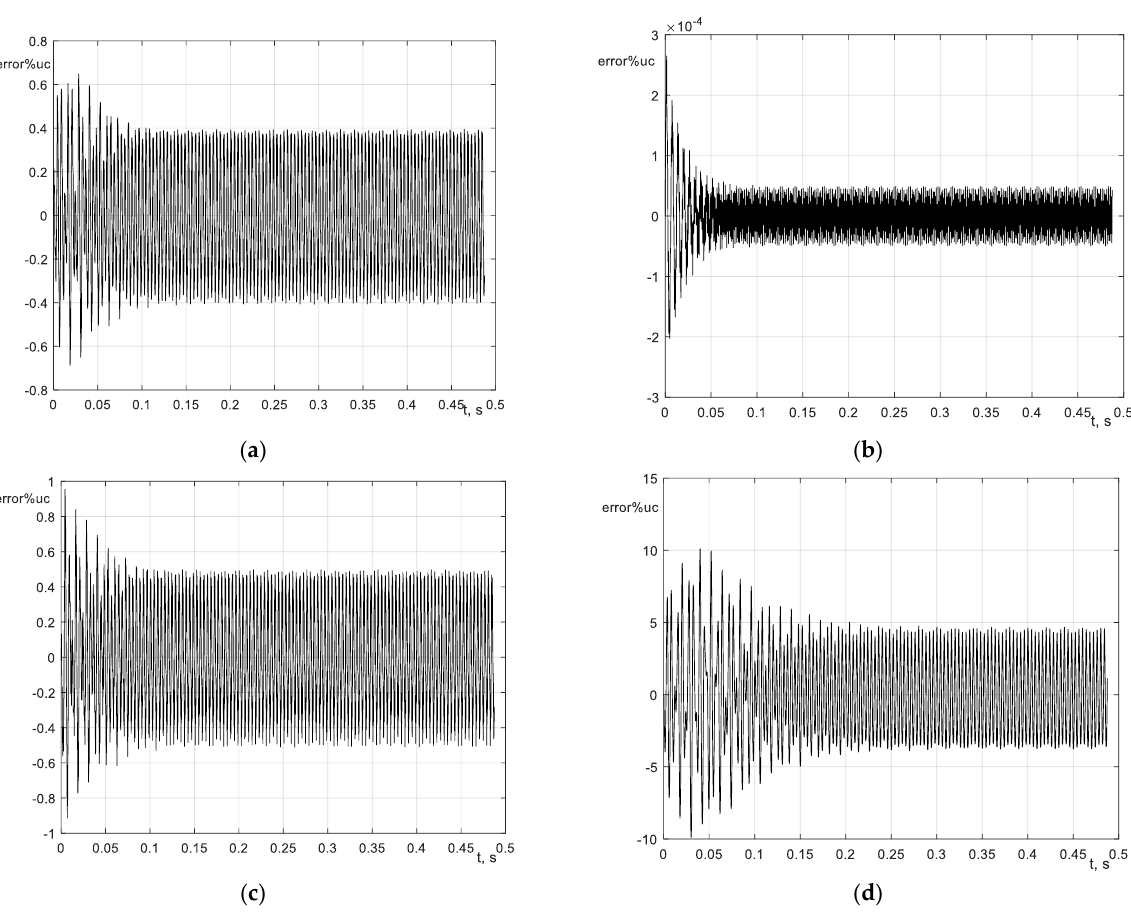
Figure 5. Errors of the function Uc (t): ( a ) algebraic polynomials; ( b ) the Chebyshev polynomials; ( c ) the Legendre polynomials; ( d ) the Hermite polynomials. ( c ) the Legendre polynomials; ( d ) the Hermite